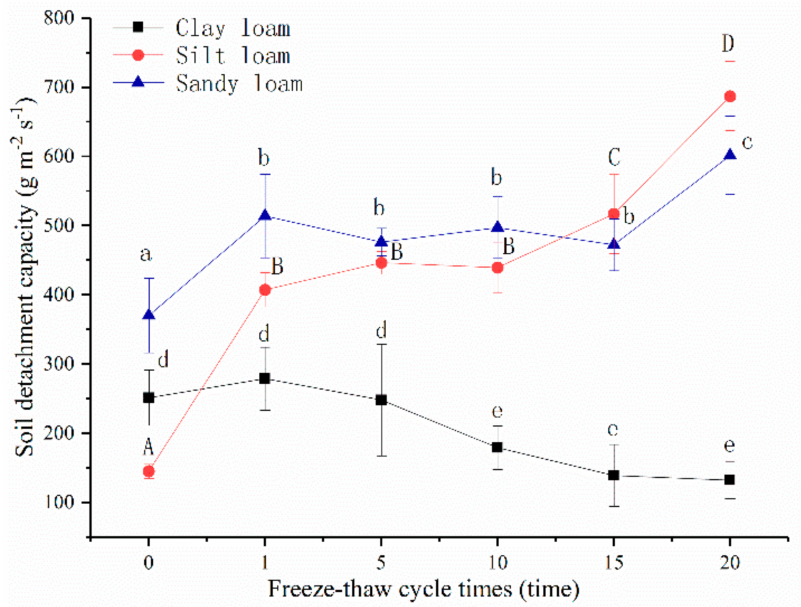
Figure 9. Variation of soil detachment capacity with freeze-thaw cycles. Note: The letters indicated whether the differences in the test results were significant or not. “a, b, c” stands for sandy loam, “A, B, C, D” stands for sandy loam, “d, e” stands for clay loam. Different letters indicate a significant difference of test results among the different freeze-thaw cycles and soils at the 0.05